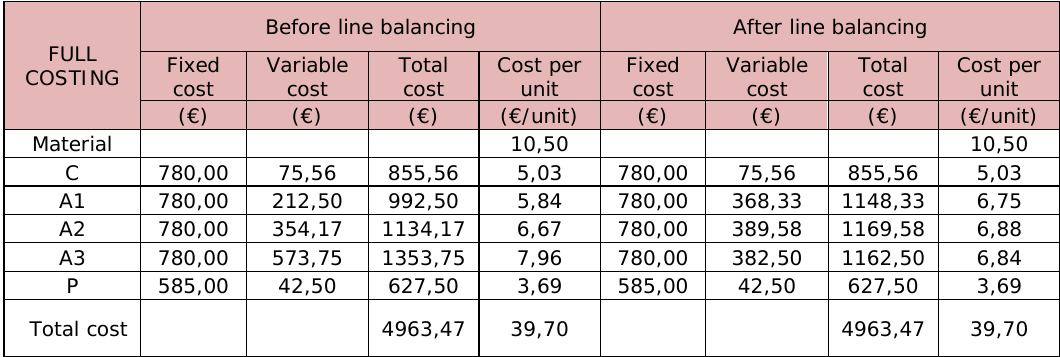
Table 10. “Calculation of the production cost, according to Full costing”. Variable cost is calculated on the average time devoted to each part before and after balancing the